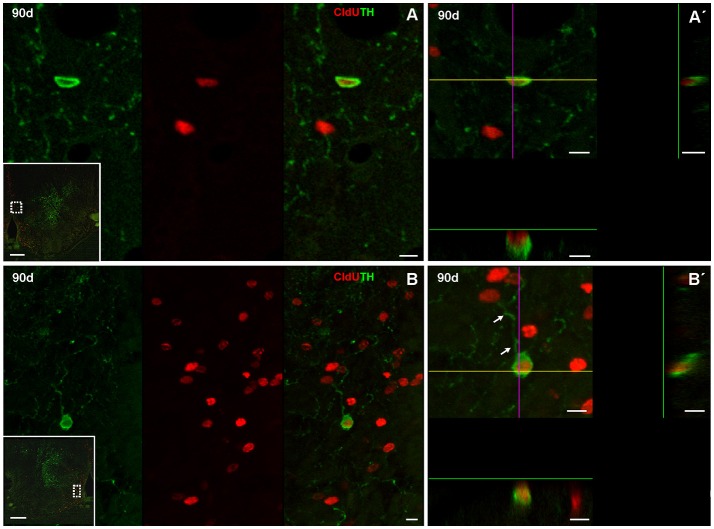
Neuronal differentiation in the rostral subpallium at 90 days after after four daily injections of CldU demonstrated by co-localization with TH. (A,B) Confocal microphotographs of the subpallium at the regions indicated by the dotted rectangles in the panoramic views (insets). Co-localization is demonstrated by TH and CldU labeling of a single confocal plane and the overlay of both images (A,B). Co-localization is also confirmed by the x-z and y-z orthogonal projections of 16 confocal planes, every 0.5 μm (A′) or 45 confocal planes, every 0.5 μm (B′). Arrows indicate neuronal processes of a newborn neuron. Scale bars: (A,B) 20 μm; (A′,B′) 5 μm; insets 100 μm.